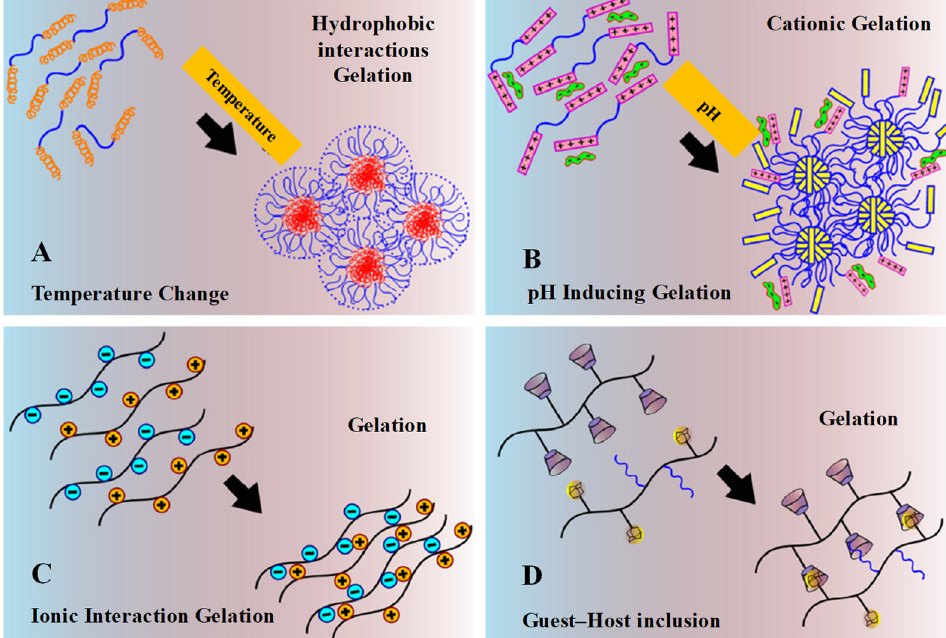
Figure 9. Schematic physical crosslinking mechanism. ( A ) Gelation driven by shifting of hydrophobic interaction under the change of temperature. ( B ) Gelation driven by pH-inducing protonation– deprotonation transition of cationic hydrogel. ( C ) Gelation by ionic interaction. ( D ) Gelation by guest–host inclusion complexation between cyclodextrin groups and adamantine groups or PEG chains. Reprinted with permission from ref. [8]. Copyright © 2015 European Polymer Journal .